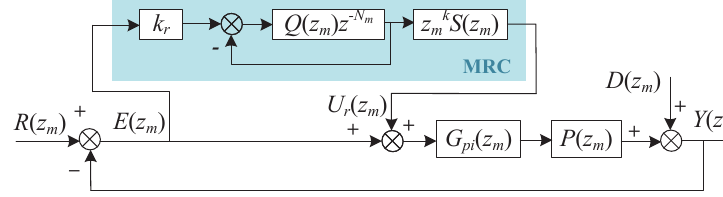
Figure 2. Equivalent single-rate control